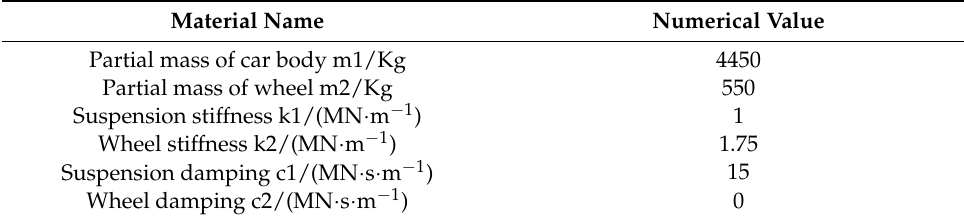
Table 1. Vehicle model